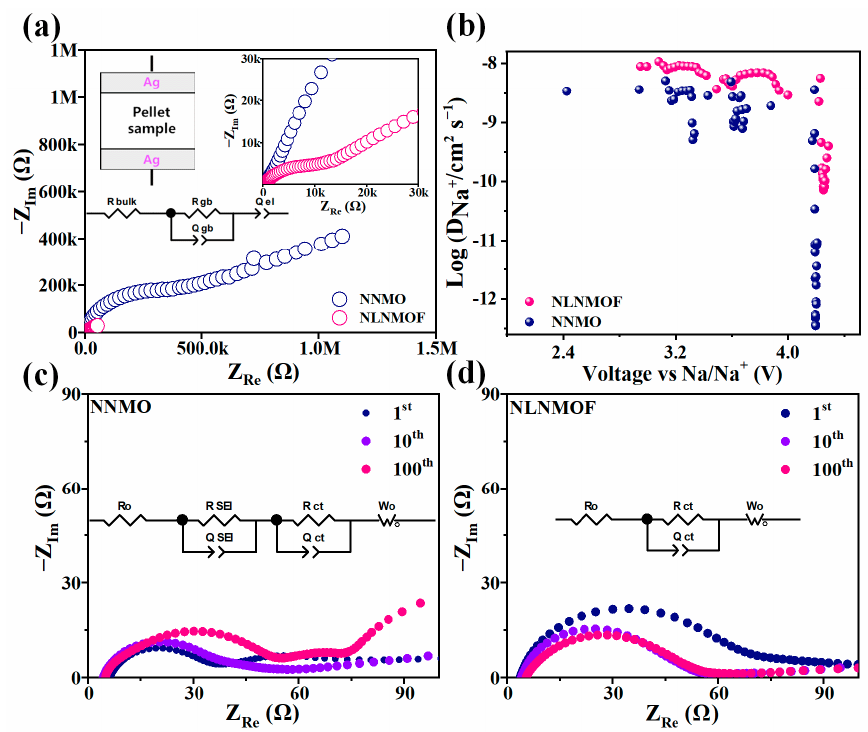
Figure 6. ( a ) Nyquist plots for NNMO and NLNMOF pellets coated with Ag paste on both sides and the corresponding fitting curves. ( b ) The sodium-ion diffusion coefficient ( D Na+ ) of Na/NNMO cell and Na/NLNMOF cell cycling between 2.0 V and 4.3 V for the charge states of the first cycle. Nyquist plot of ( c ) NNMO and ( d ) NLNMOF, respectively, and the equivalent circuit is shown in the inset.